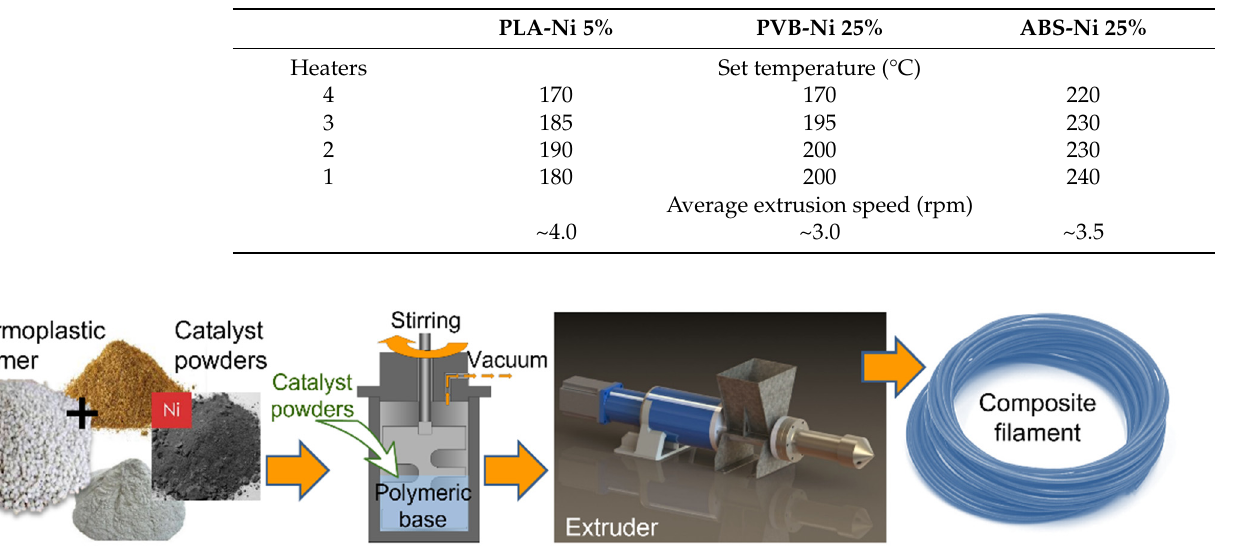
Table 2. Composite filament extrusion temperatures and speeds for selected composite materials; heating zones are numbered from screw (1) to nozzle (4).